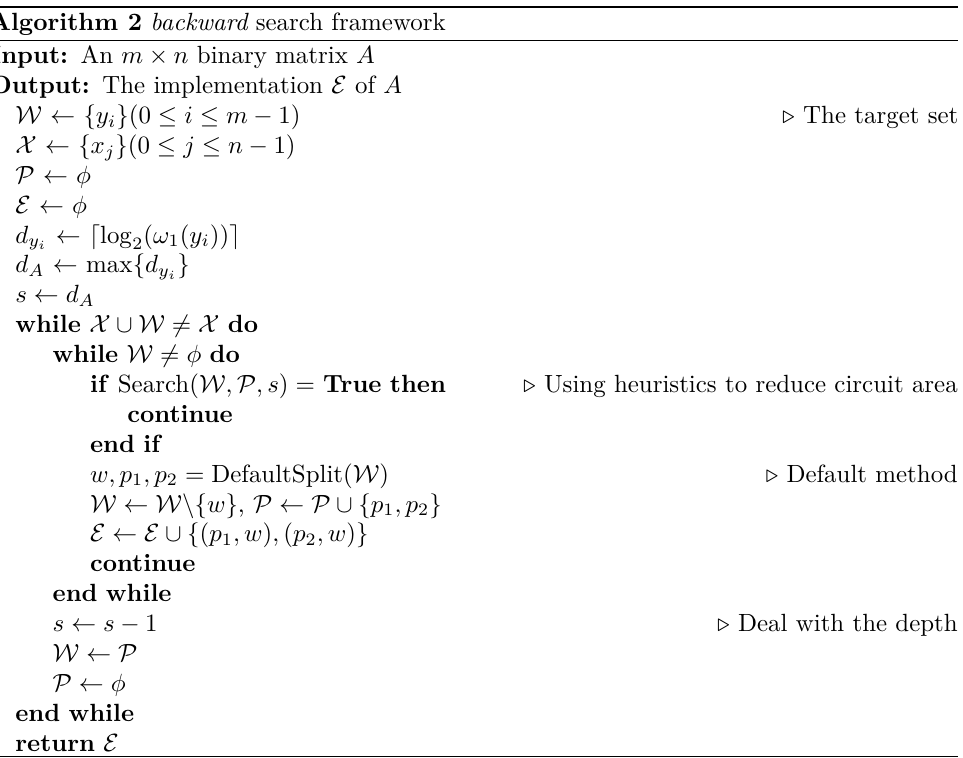
Algorithm 2 backward search